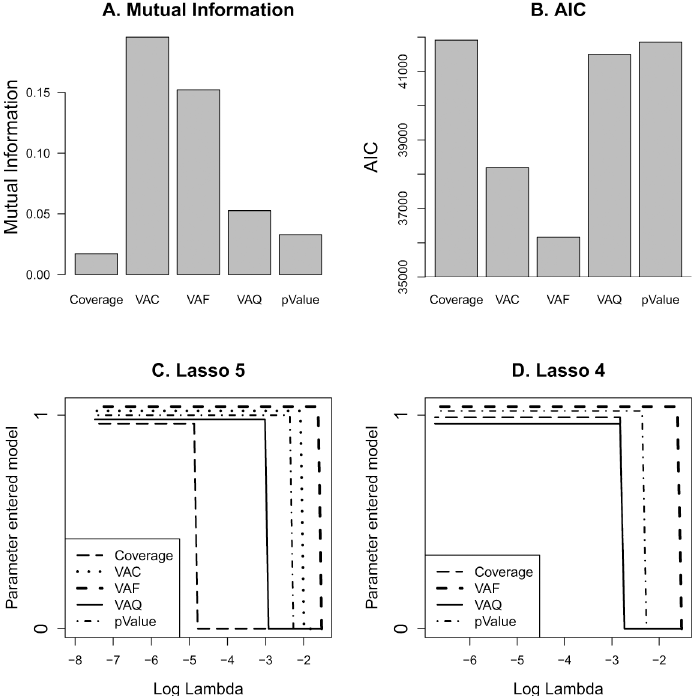
Fig 4. Comparisons between the relative importance of the 5 different variables in determining reproducibility of SNV calls. Importance was assessed using mutual information value (A), Akaike information criterion (B), and Lasso regression methods (C, D). On panels C and D, the y-axis indicates whether a factor is in the model (y = 1) or not (y = 0). VAC = variant allele count, VAF = variant allele frequency, VAQ = variant allele quality and p-value refers to SNP call p-value generated by